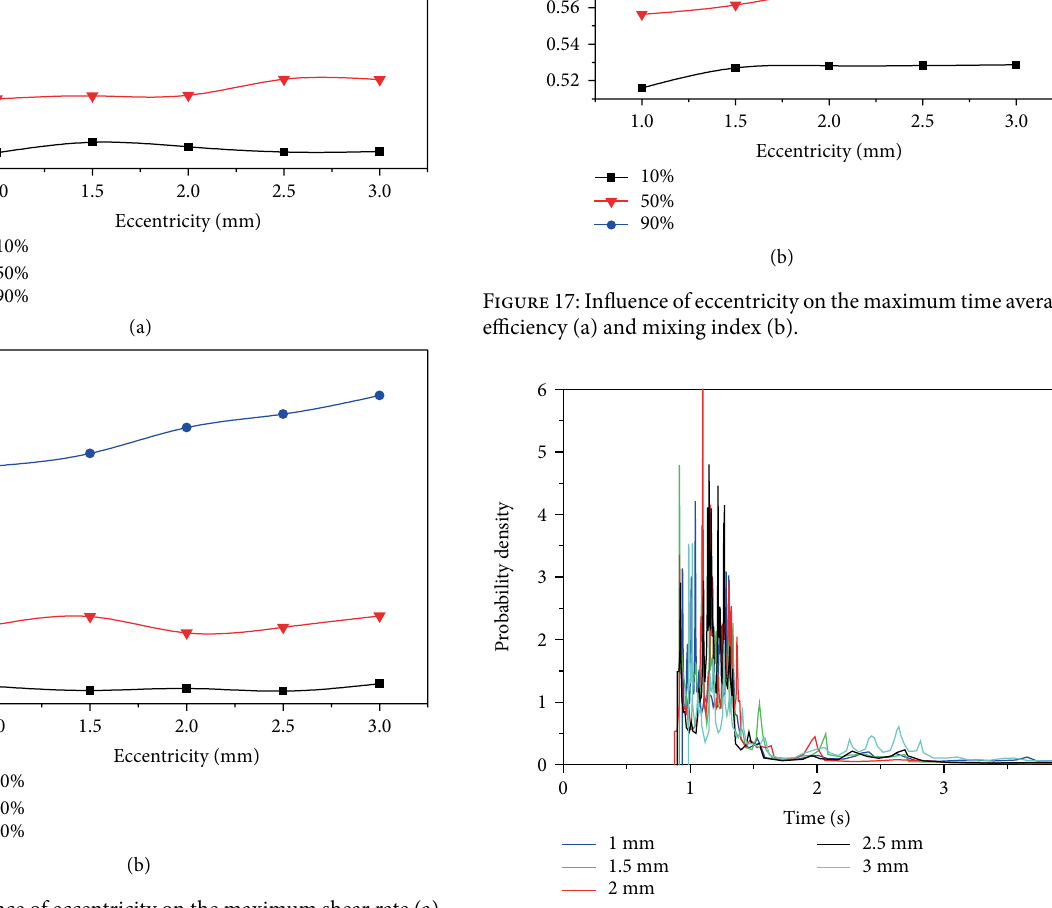
Figure 18: Influence of eccentricity on residence time distribution.